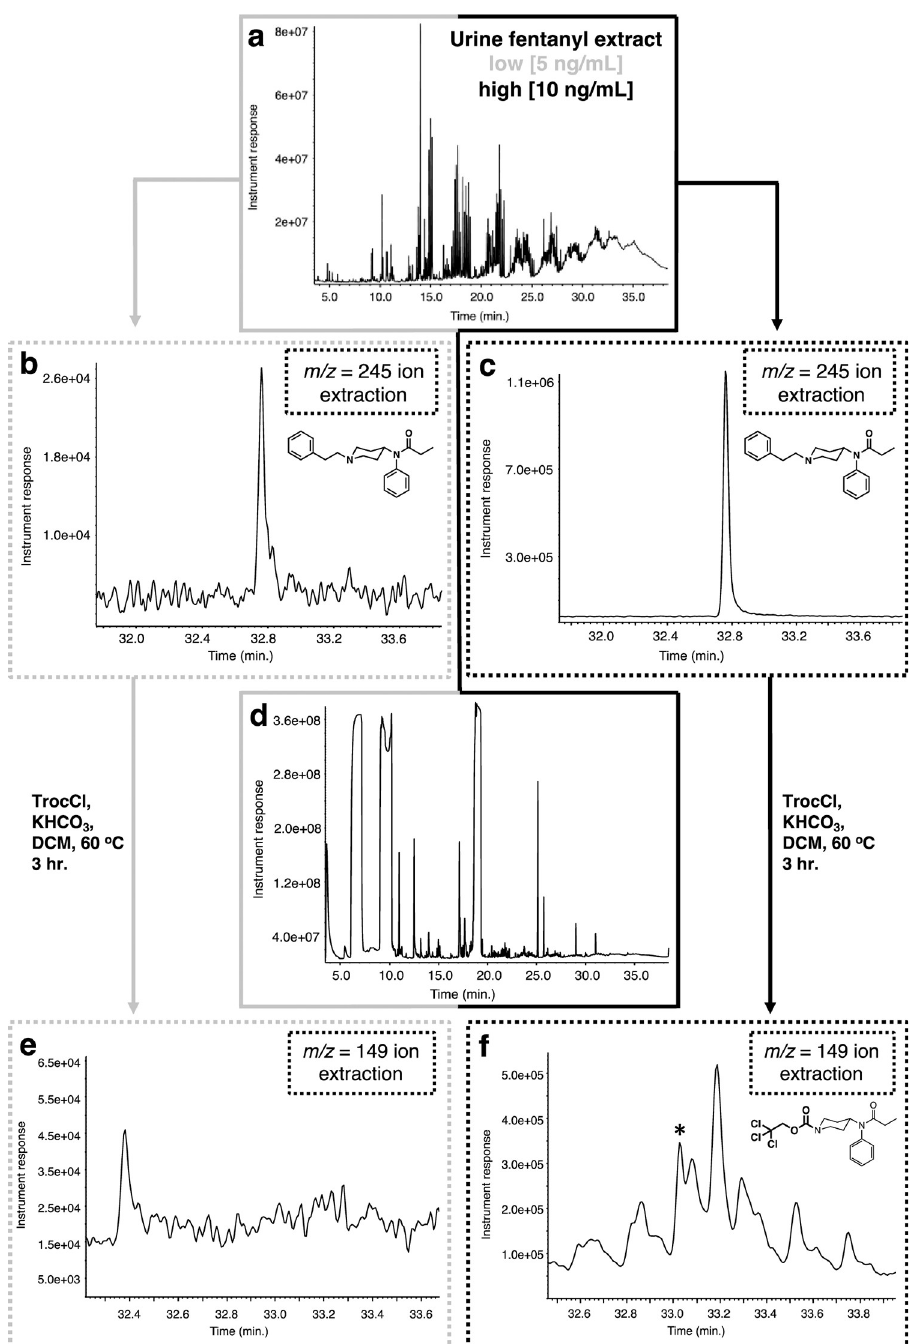
Fig 5. Extraction and reaction of fentanyl with Troc-Cl when spiked in urine. (a) GC chromatogram of extracted urine sample; (b) extracted ion (m/z = 245) chromatogram for fentanyl (rt = 32.8 min.) for low concentration urine spike (5 ng/mL); (c) extracted ion (m/z = 245) chromatogram for fentanyl for high concentration urine spike (10 ng/ mL); (d) GC chromatogram of the reaction between extracted urine sample and Troc-Cl; (e) extracted ion (m/z = 149) chromatogram for Troc-norfentanyl for the low concentration urine sample (rt = 33.03 min.); (f) extracted ion (m/ z = 149) chromatogram for Troc-norfentanyl for the high concentration spiked urine sample.